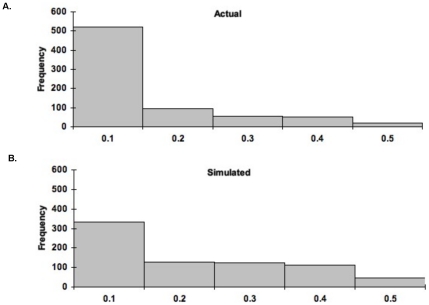
Histogram of the SFS for (A) actual and (B) simulated MAFs.Distributions are significantly different (p<<0.001).